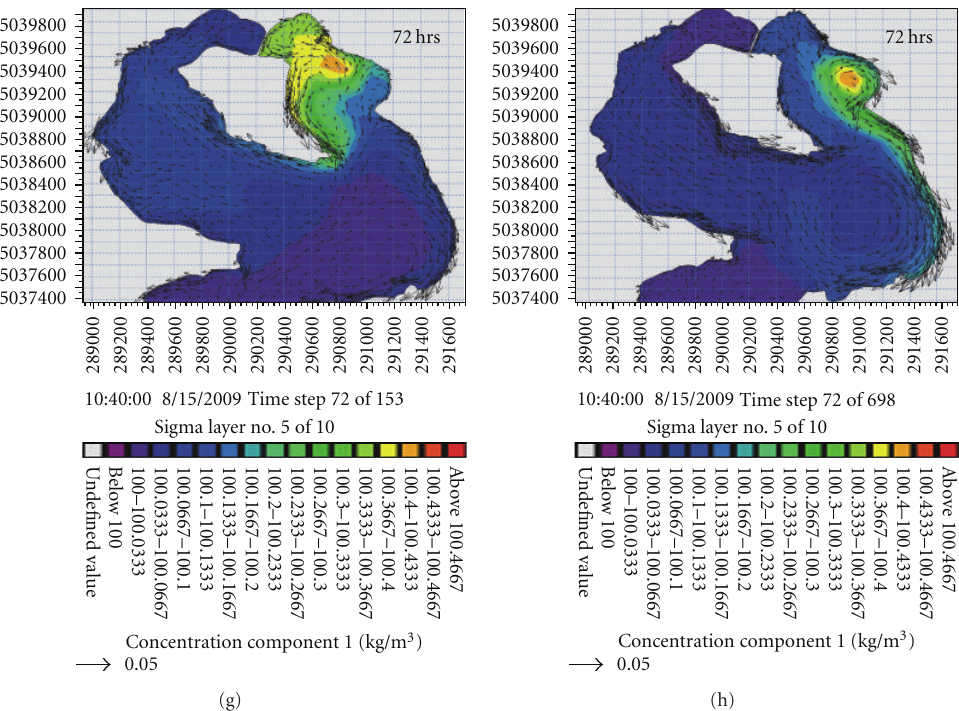
Figure 28: The simulated time series of the transport of the STP discharge plumes at the middle water depth in the north basin after travelling for 24, 48, 60, and 72 hours under north-east (left side panels) and north-west (right side panels) winds of